Question: Briefly state, in one sentence, what is plotted here.
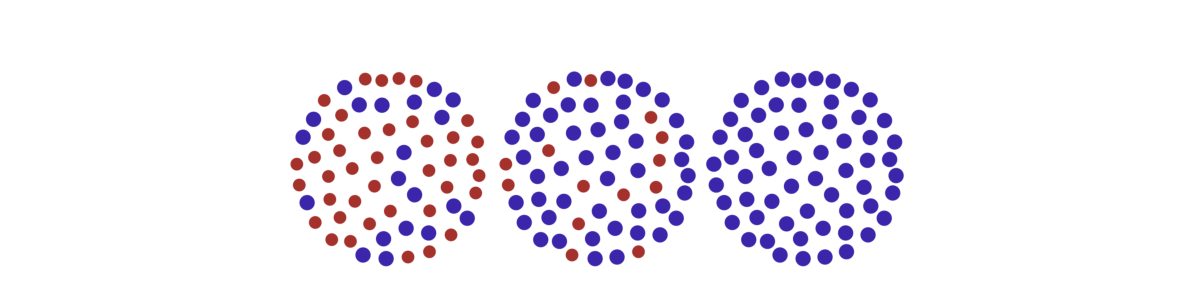
Answer: Three stages in a Moran process, from left to right, that models evolutionary dynamics in a fixed population of finite size.